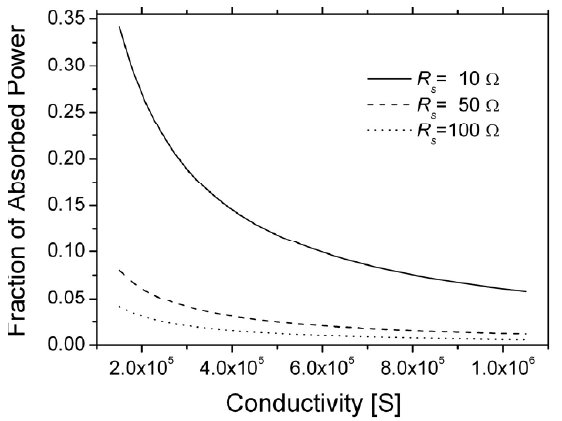
Fig. 2. TCO film thickness as function of film con-